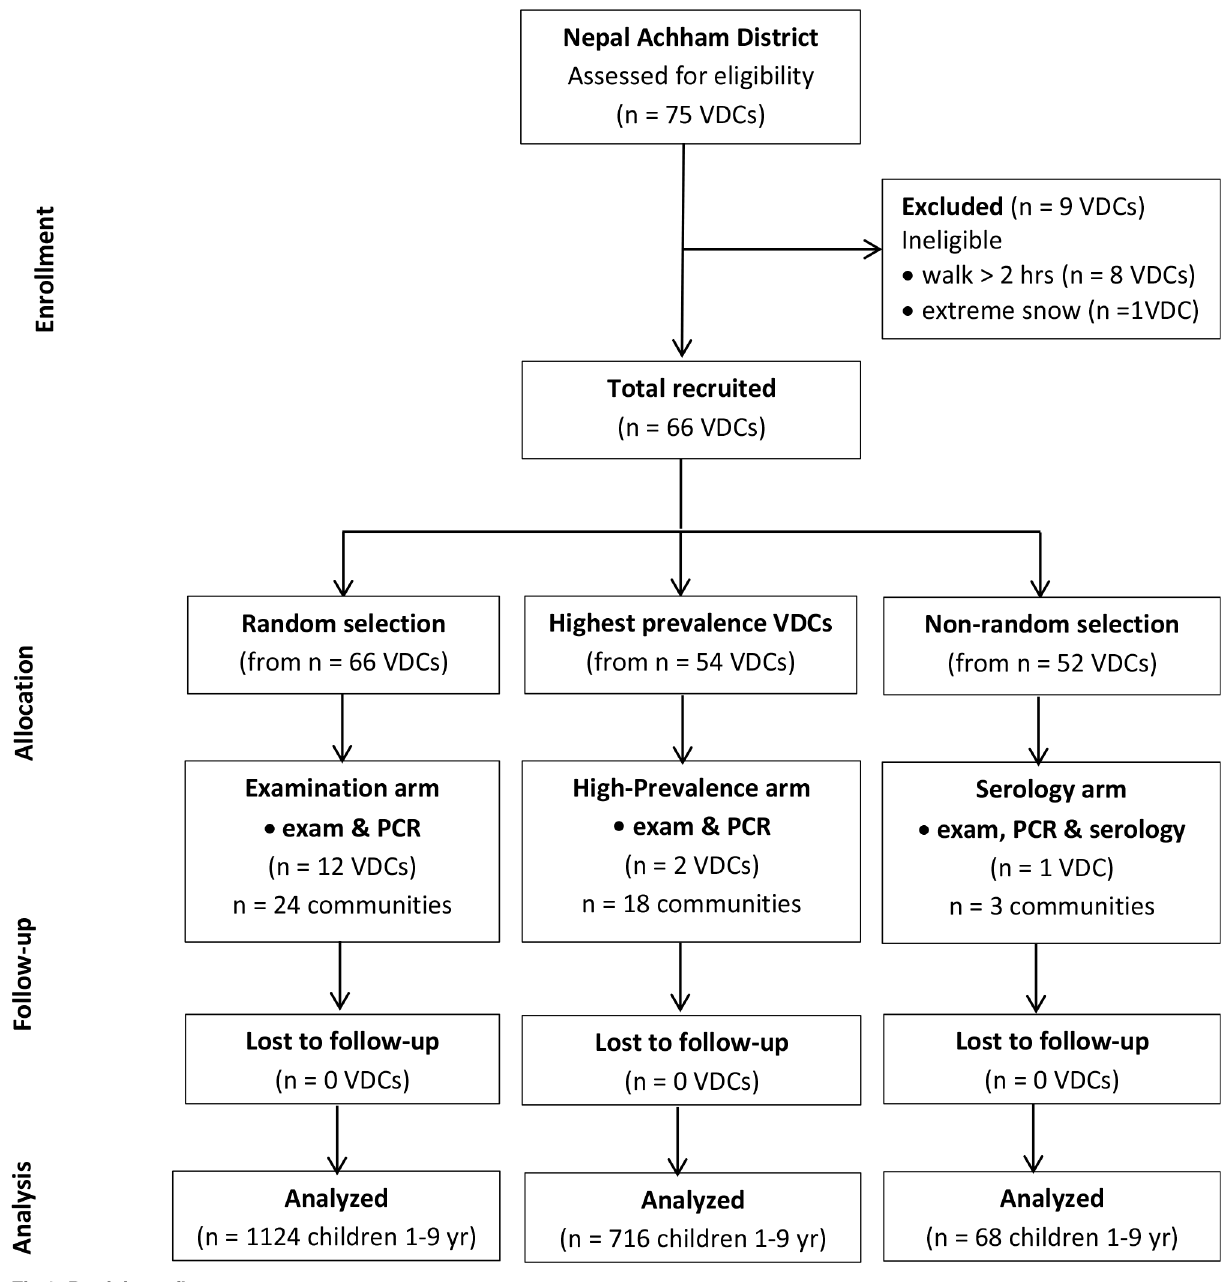
Fig 1. Participant